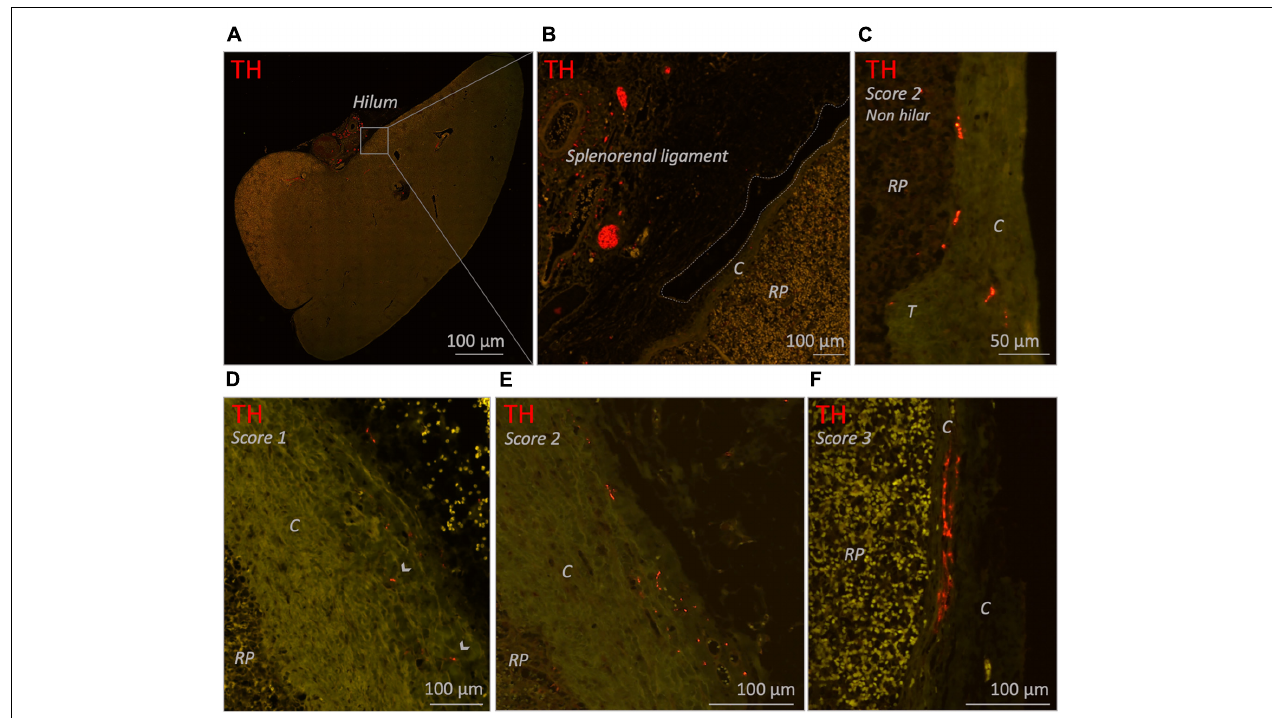
FIGURE 4 | Fluorescence microscopic images of various capsule related sympathetic nerve densities (TH staining). (A) Overview image of a neonatal spleen. Large blood vessels with a perivascular nerve plexus reside in the splenorenal ligament and enter the spleen at the hilum. (B) Close up images of the boxed region in (A) . The splenorenal ligament contains connective tissue, vascular structures and sympathetic nerves. The lining of the splenorenal ligament reflects over the hilar capsule and on its distal continuation thins out (dotted line shows the lining of the ligament). (C) Close up image of a part of a capsule obtained from a non-hilar part of a neonatal spleen. A moderate density (score 2) of sympathetic nerves can be observed. (D,E) Close up images of hilar capsule samples of spleens of individuals from the 25–70 years age group containing a low (score 1) and moderate (score 2) density of sympathetic nerves, respectively. (F) Close up image of hilar capsule sample of a neonatal spleen with a high (score 3) density of sympathetic nerves. Capsular nerves were mostly observed in the more superficial and middle part of the capsule and only sporadically in the deeper part where they were in direct contact with the red pulp (as shown in C ). C, capsule; RP, red pulp; T, trabecula. Arrow heads: small capsular